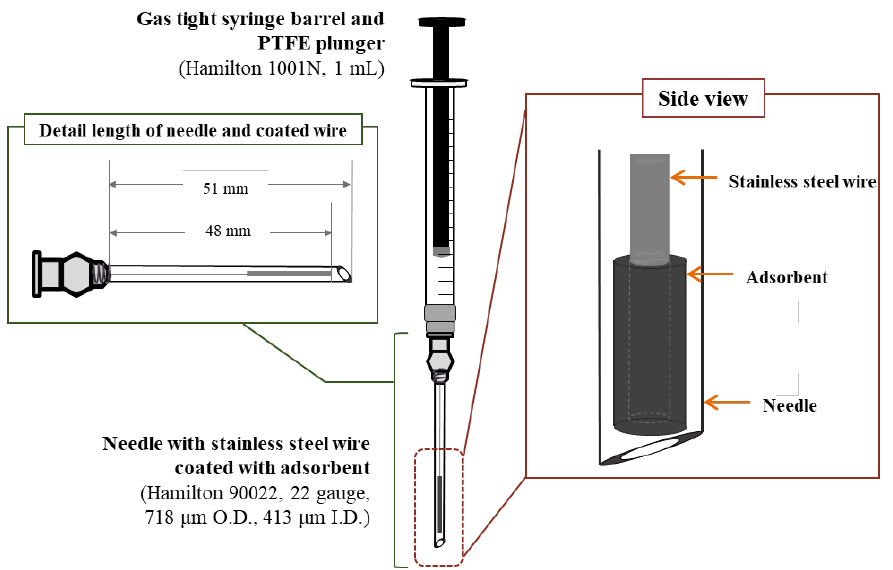
Figure 4. A schematic illustration of the side view and details of each length of a needle containing a stainless-steel wire coated with MWCNT−IL/PANI.